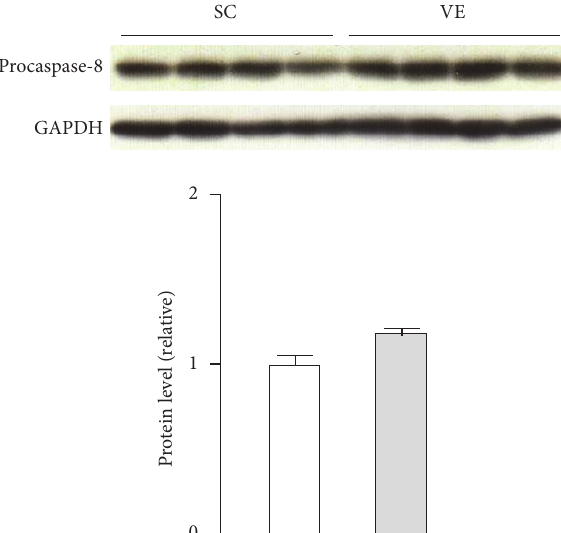
Figure 9: Effects of regular voluntary exercise (VE) on the protein levels of procaspase-8 in macrophages. Immediately after peritoneal- exudate macrophages were isolated from the sedentary control (SC) and VE mice, whole cellular proteins were extracted. The protein levels of procaspase-8 were analyzed by western blotting (upper panel). The protein levels are presented as ratios relative to the levels of glyceraldehyde 3-phosphate dehydrogenase (GAPDH) (lower panel). Mean ± standard error of the mean (SEM; 𝑛 = 4 ) values are provided.